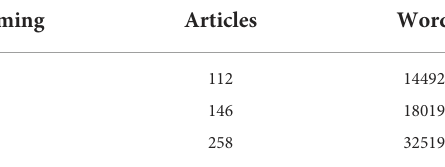
TABLE 2 Corpus composition, broken down by tabloid vs. broadsheet and “pre-naming” vs.